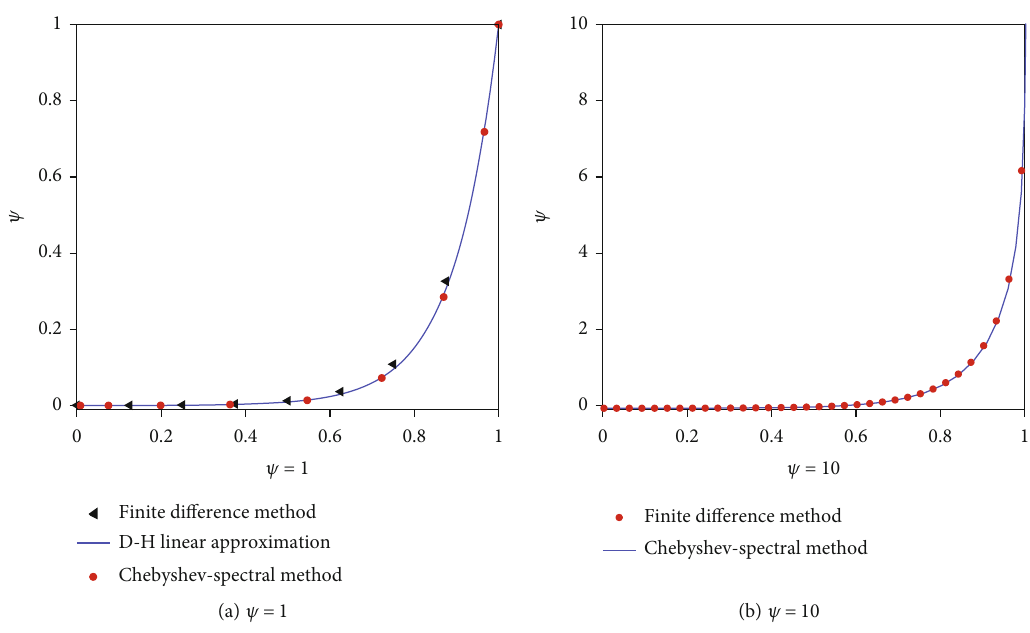
Figure 2: Comparison of Chebyshev spectral method for nonlinear P-B equation with fi nite di ff erence numerical solution and D-H linear approximate analytical solution ð K = 10 Þ